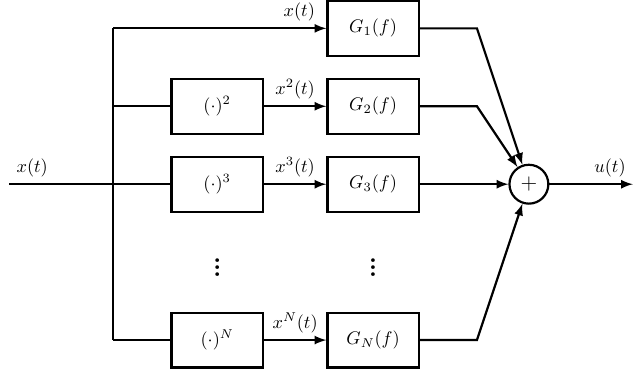
Figure 2. Generalized Hammerstein model for identifying the nonlinearities of the pickup; x ( t ) and u ( t ) represent the displacement of the guitar string and the output voltage of the pickup,